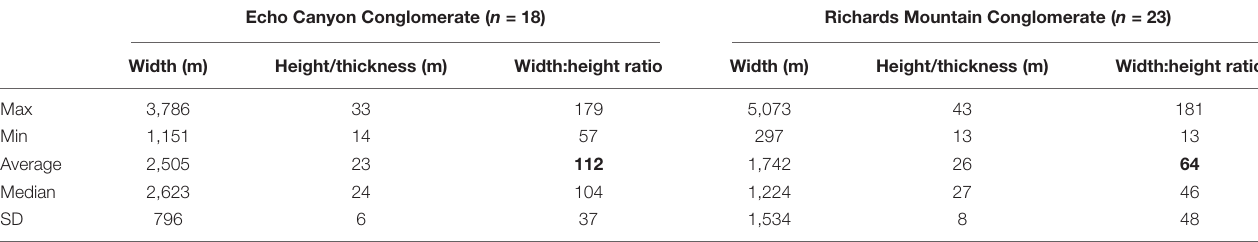
TABLE 3 | Fifth-order lithosome dimensions and width:height ratios. Echo Canyon Conglomerate ( n = 18) Richards Mountain Conglomerate ( n = 23) Width:height